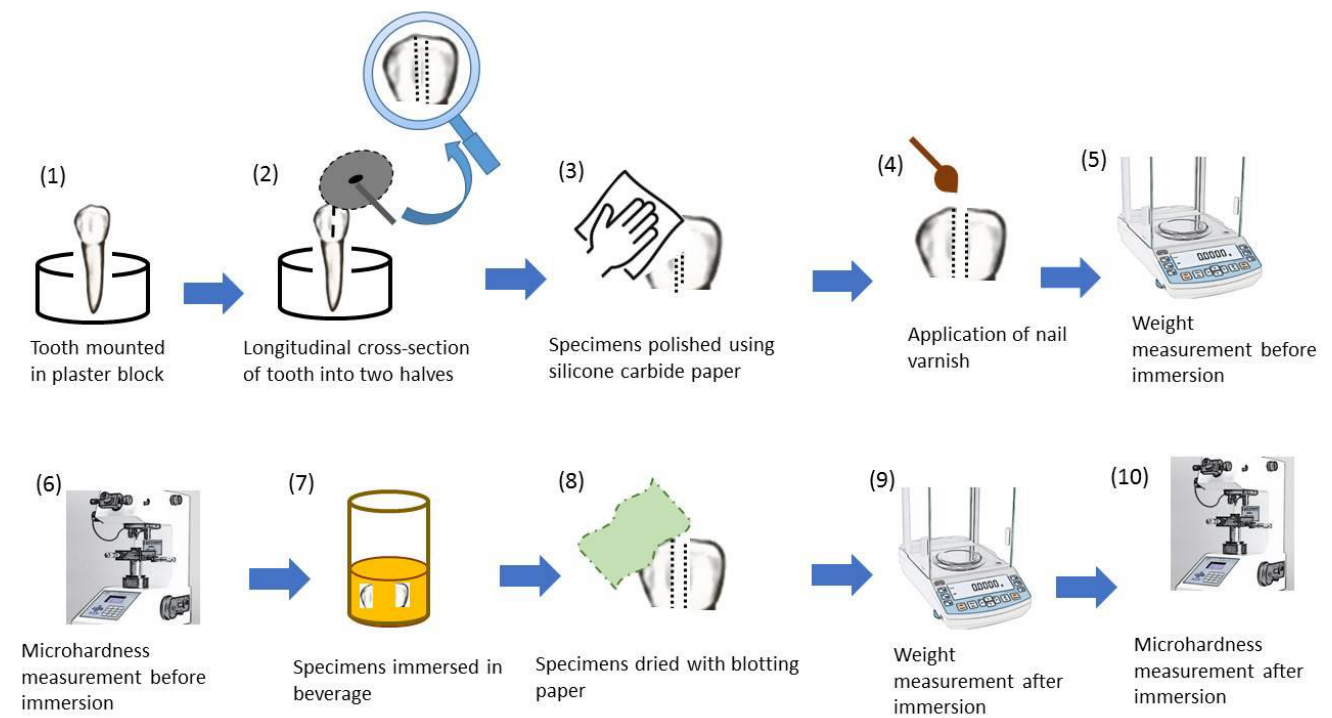
Figure 3. A schematic diagram showing a complete representation of the experiment from tooth sectioning to measurement of surface hardness and weight.